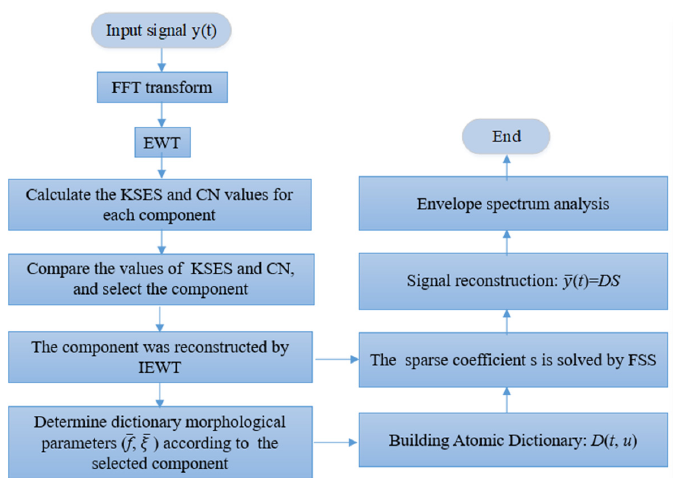
Figure 2. Flowchart of Algorithm for Feature Extraction of Weak Faults of Rolling